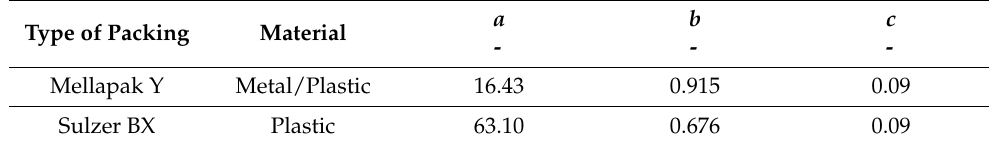
Table 5. Characteristic parameters in Equation (53) for different packings